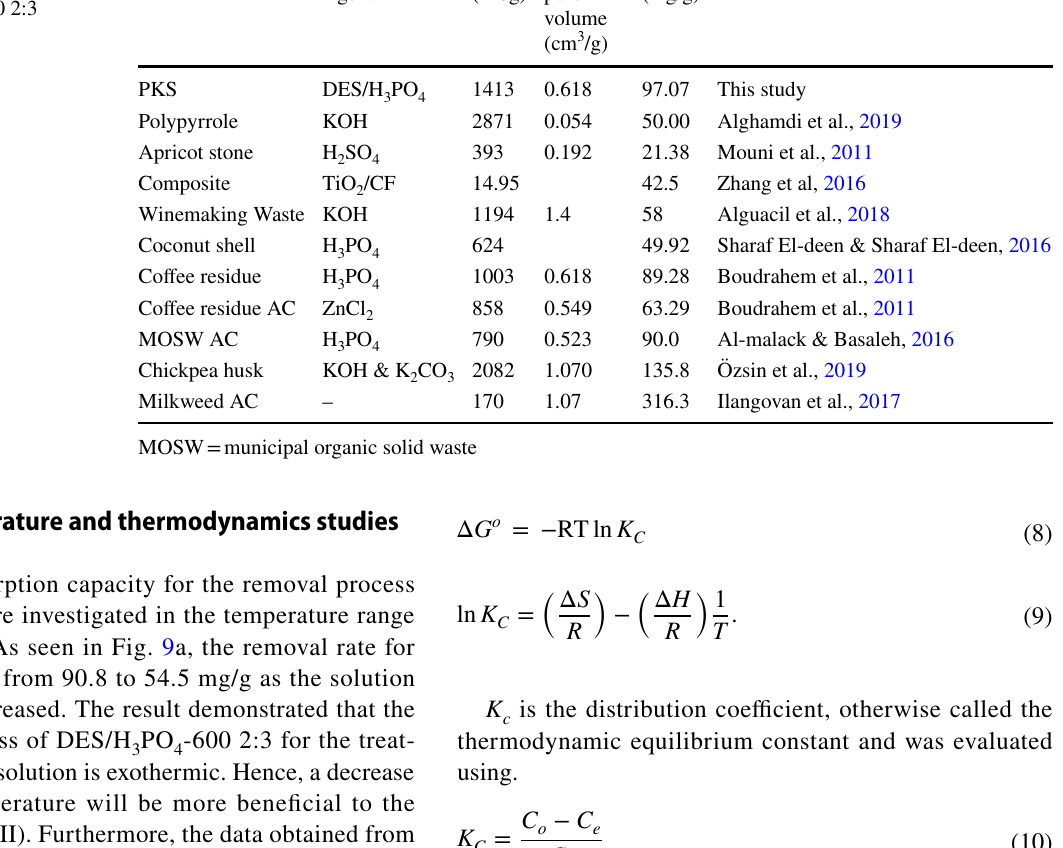
Table 3 Adsorption capacity of various adsorbents compared with DES/H 3 PO 4 -600 2:3